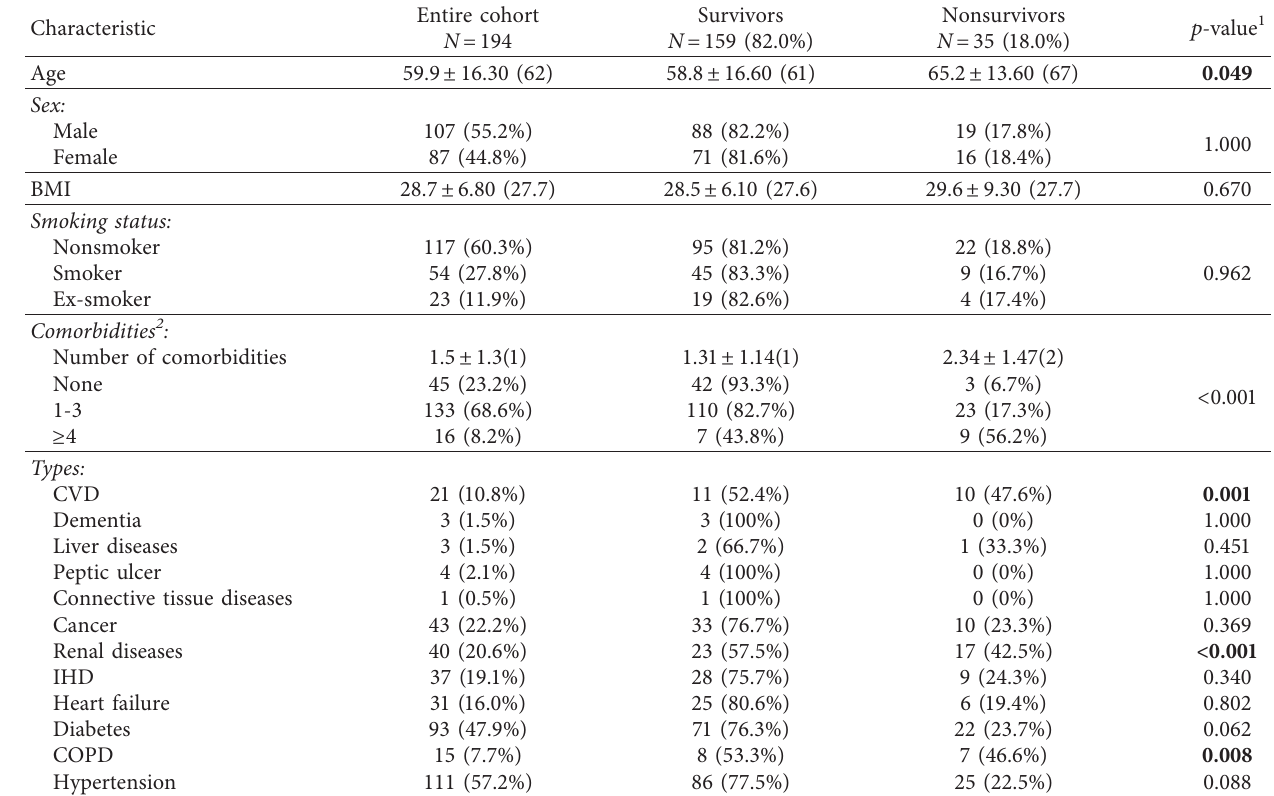
Table 1: Demographics and comorbidities of the study cohort divided by outcome.